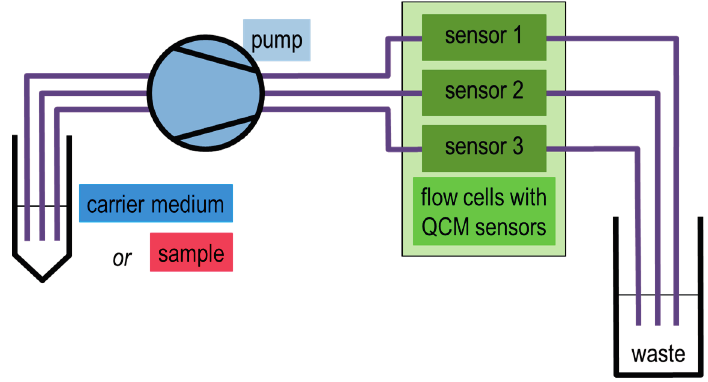
Figure 5. Flow system used for the QCM sensor measurement setup. Either carrier medium or sample was driven by a pump through the flow